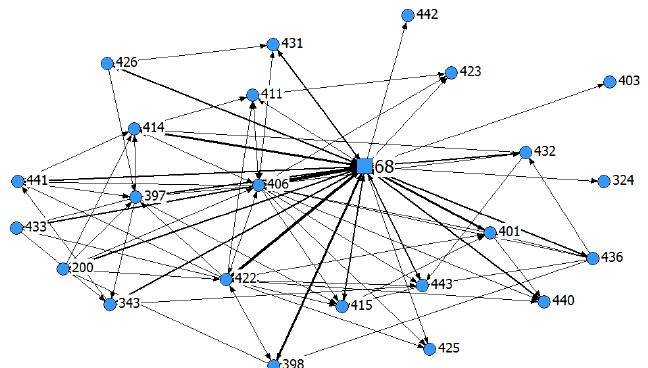
Figure 1 The network of interactions between learners and the tutor In UCINET, the density analysis along Networks-Cohesion- Density-Density indicates that the density reaches 0.97, almost equal